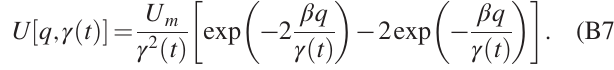
FIG. 5. Phase-space volume Ω ð E; γ Þ corresponding to U ð q; γ Þ [Eq. (B7)] for E ¼ − 1 = 2 and γ ¼ 1 (dashed blue line) and γ ¼ 1 = 2 (solid red